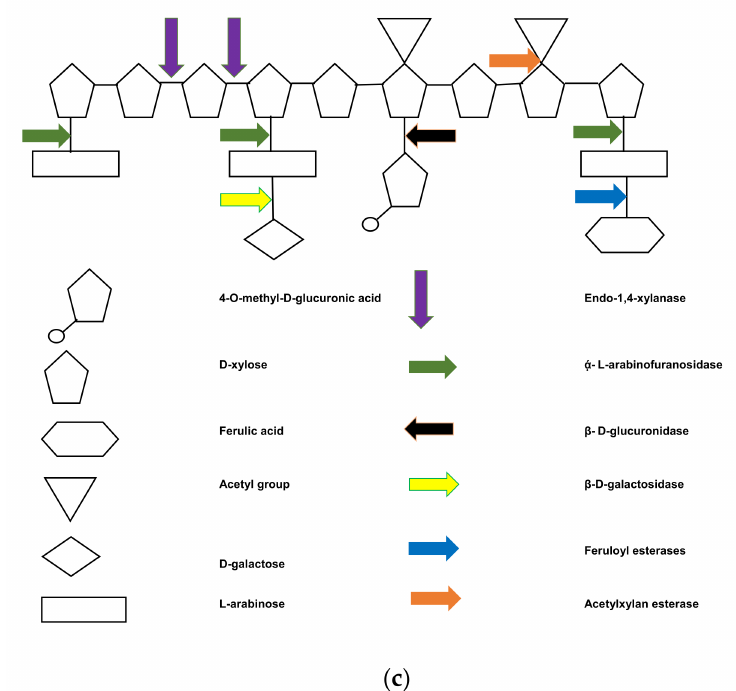
Figure 1. Molecular structures of products of ( a1 ) ligninolysis and ( a2 ) holocellulolysis; ( b ) process of cellulolysis including enzymes at each biocatalysis step, and ( c ) enzyme action site involvement in hemicellulolysis including